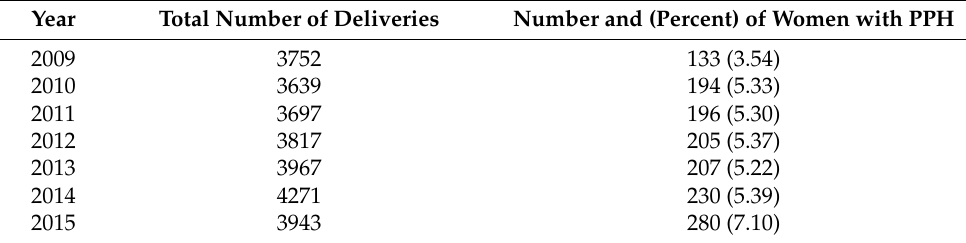
Table 3. Rate of PPH per Year from 2009–2015.